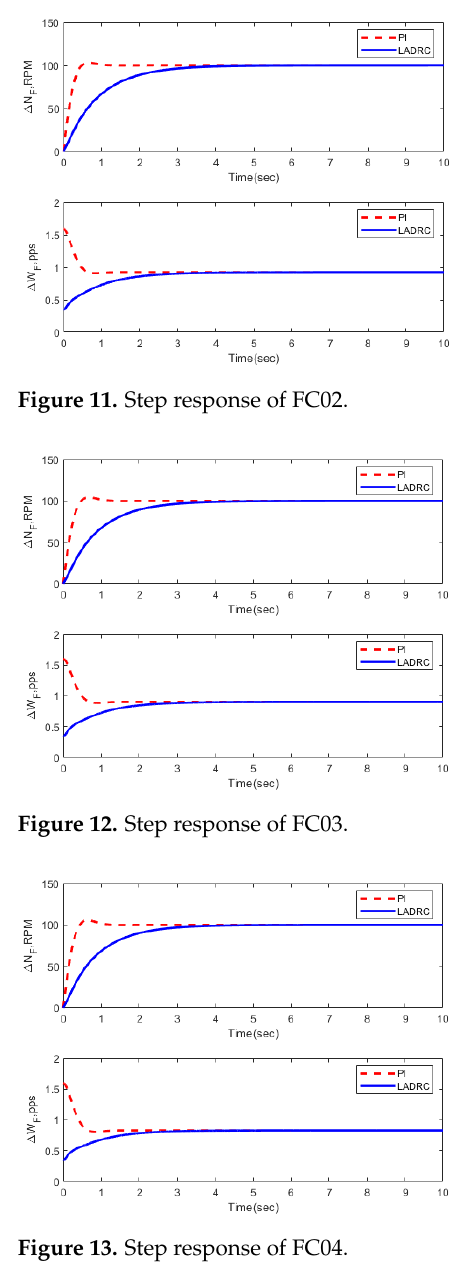
Figure 10. Step response of FC01.